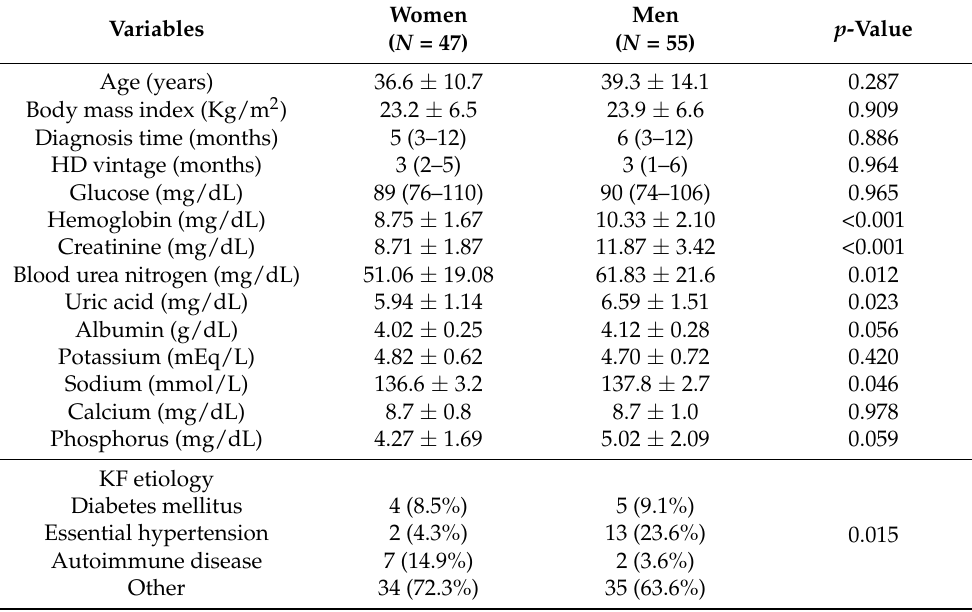
Table 1. Anthropometric characteristics, comorbidities, and laboratory results for 102 kidney failure (KF) patients treated with hemodialysis (HD) or hemodiafiltration. Data are shown as mean ± standard deviation, median (percentile 25–percentile 75), or absolute frequency